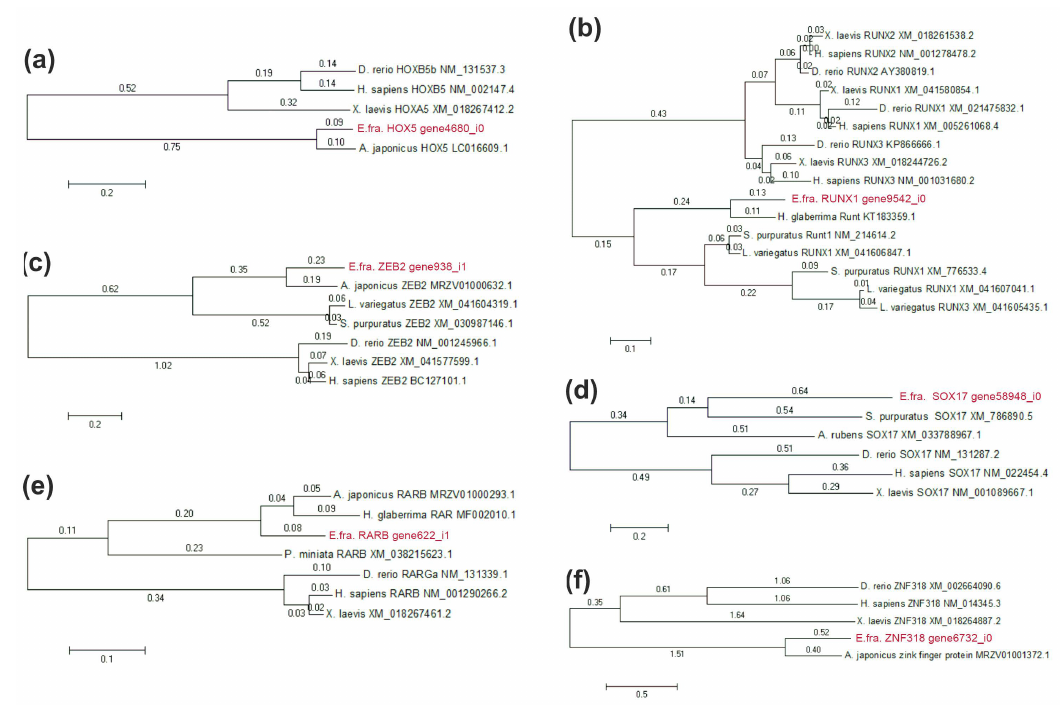
Figure 5. Phylogenetic trees showing the relationships of the TF sequences of the E. fraudatrix with homolog proteins of other animals. ( a ) HOX5; ( b ) RUNX1; ( c ) ZEB2; ( d ) SOX17; ( e ) RARB; ( f ) ZNF-318. The values on the branches indicate their length. The phylogenetic trees were constructed using the Maximum Likelihood algorithm in the MEGA11 program.